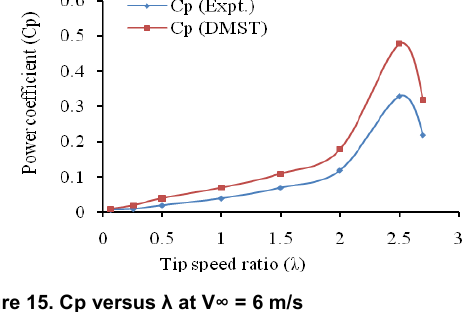
Figure 15. Cp versus λ at V ∞ = 6 m/s